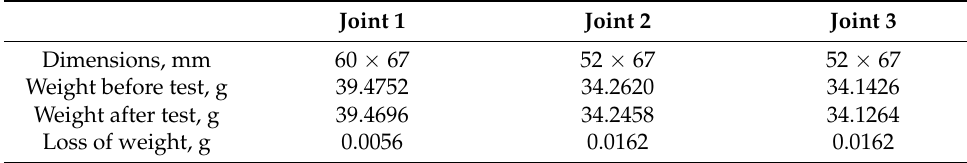
Figure 8. View of the samples during the salt spray test. Table 6. Results of mass loss and mass loss relative to the surface after corrosion tests.